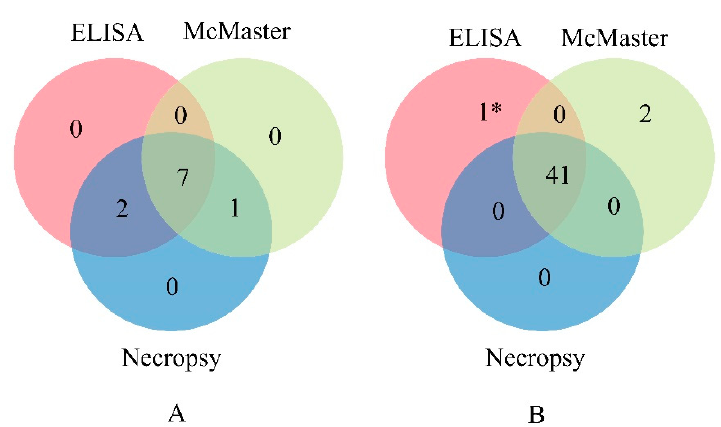
Figure 5. Venn diagram showing the positive ( A ) and negative ( B ) samples as tested by ELISA, McMaster, and necropsy. 1* represents that 1 sample was found to be a false positive/negative by ELISA.